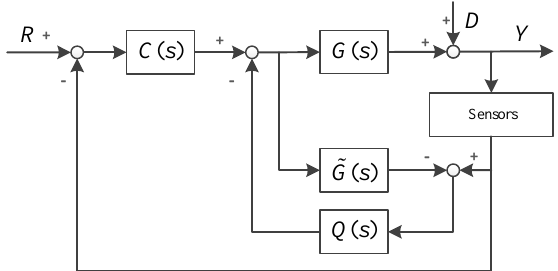
Figure 3. Schematic diagram of a closed loop with disturbance observer.